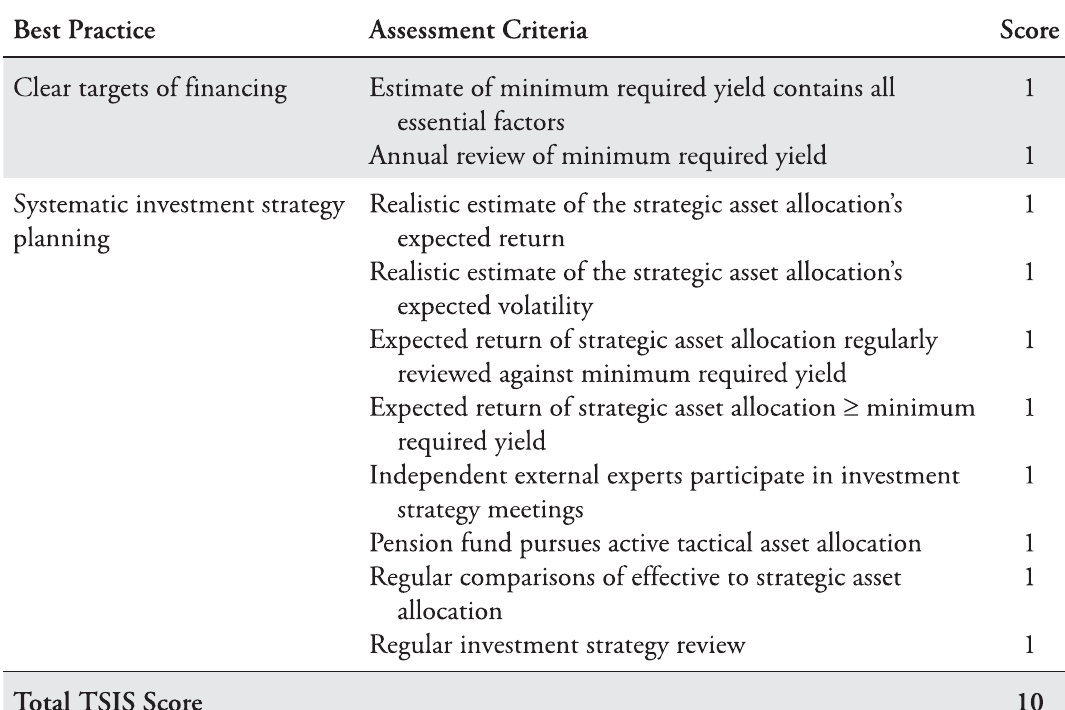
Table 3: Composition of the TSIS